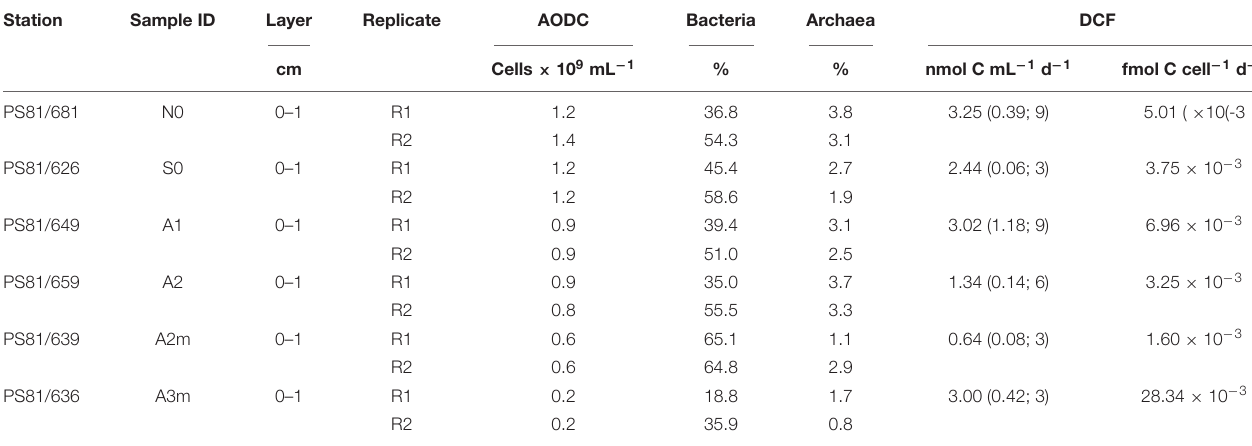
TABLE 3 | Benthic microbial abundances and